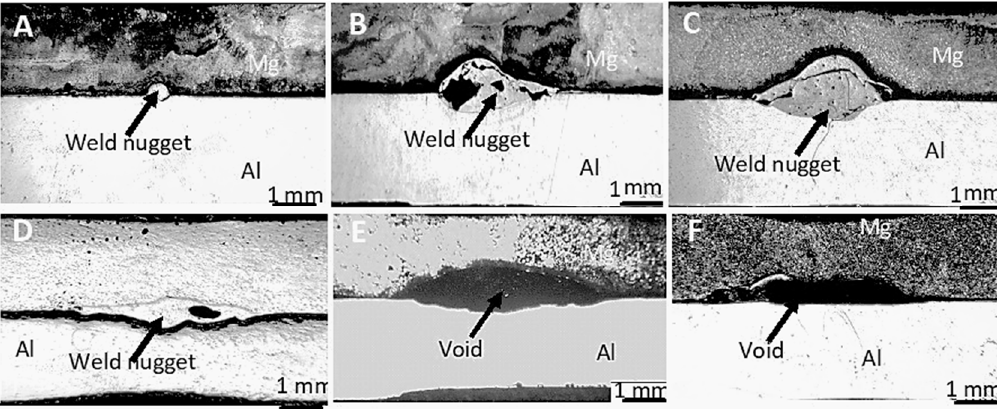
Figure 1. Optical micrograph of the nugget formed as a function of welding time: ( A ) 100 ms, ( B ) 200 ms, and ( C ) 300 ms using a constant clamping force of 800 N, and a clamping force of ( D ) 600 N, ( E ) 1000 N, and ( F ) 1200 N using a constant welding time of 300 ms .